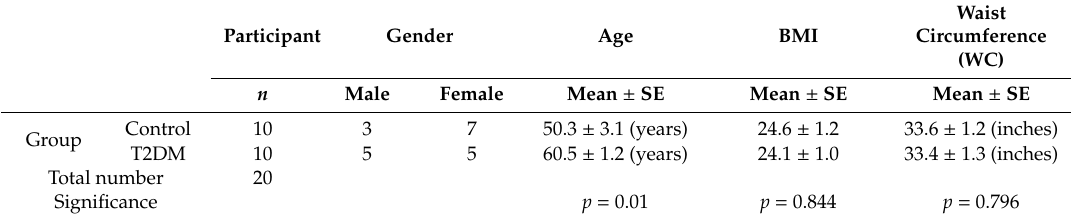
Table 1. Comparison of anthropometry (BMI and waist circumference) between T2DM group and control group.